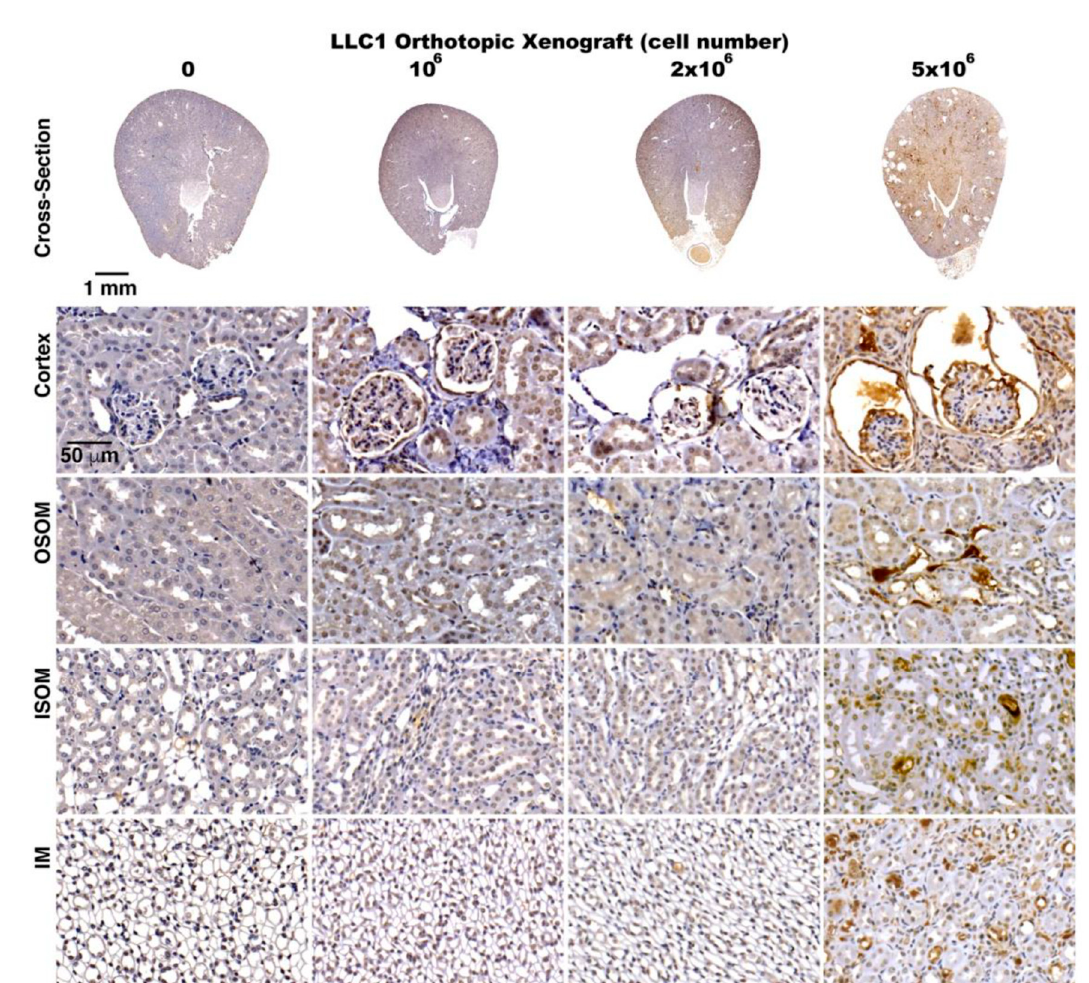
Figure 6. TGF- β as a pathogenic signaling of renal fibrosis in the kidneys of lung cancer mice. The role of TGF- β signaling in paraneoplastic renal fibrosis in the kidneys of the mice with LLC1 cells was evaluated using an antibody against TGF- β to determine TGF- β distribution in the kidneys. Fewer TGF- β signals were detected in the sham mice compared to increasing signals in the mice with increasing numbers of LLC1 cells. More TGF- β signals were noted in the cortex, outer stripe of the outer medulla (OSOM), inner stripe of the inner medulla (ISOM), and inner medulla (IM) in the kidneys of the lung cancer mice. Bar = 50 μ m